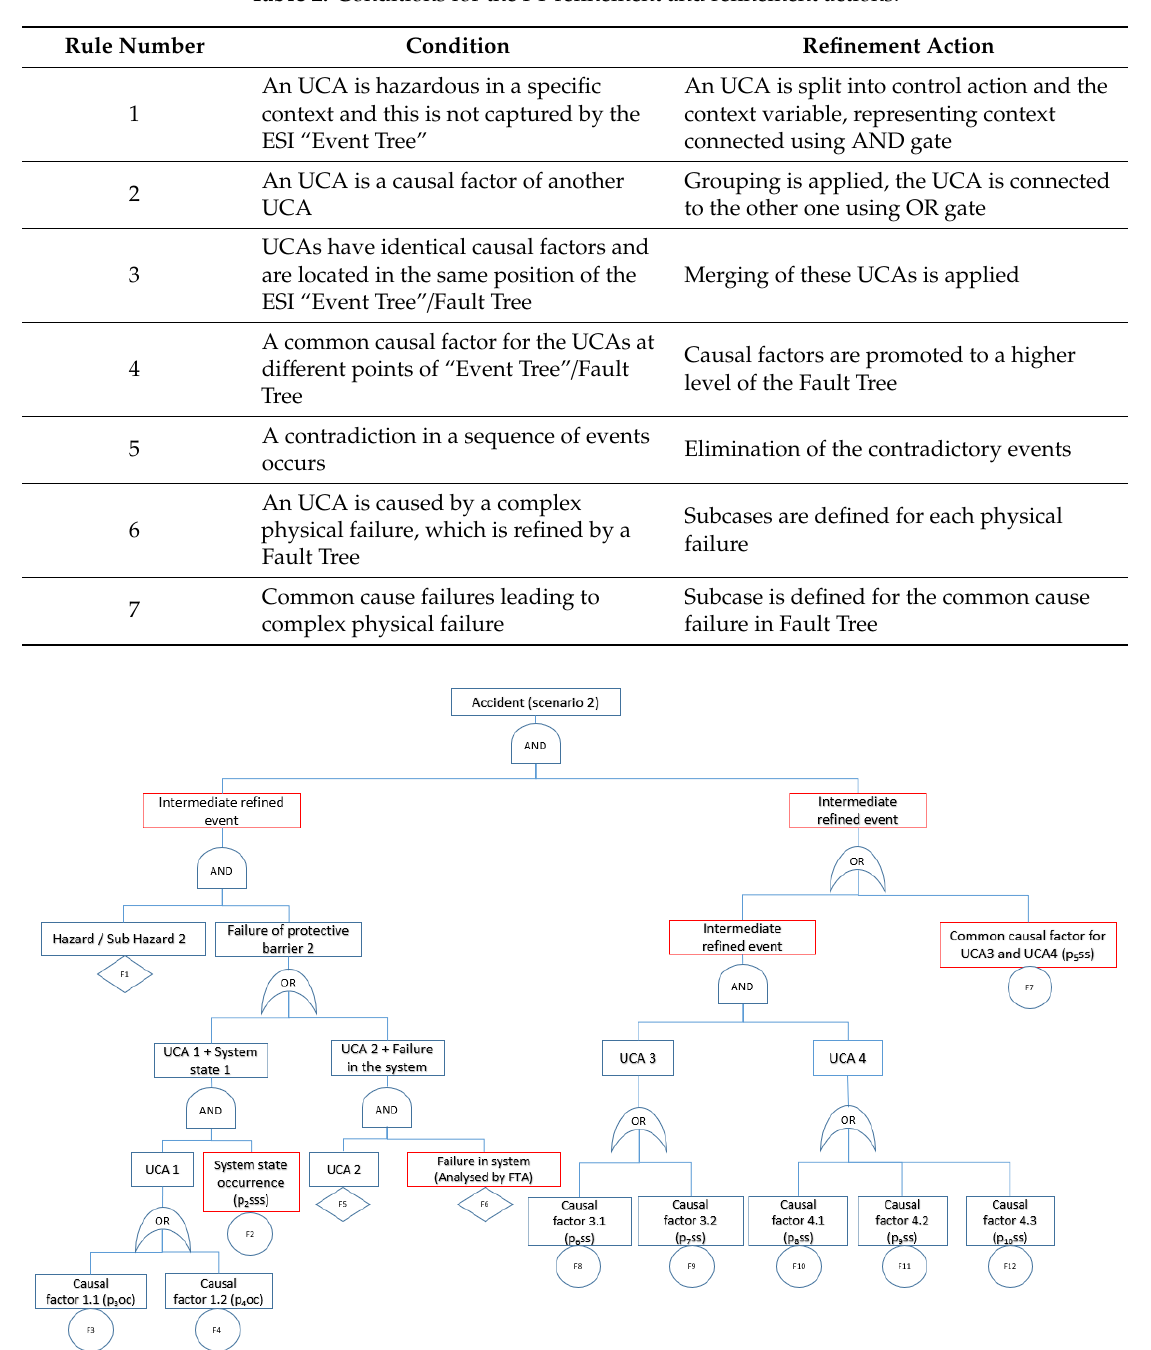
Figure 6. Refined Fault Tree example. Table 2. Conditions for the FT refinement and refinement actions.